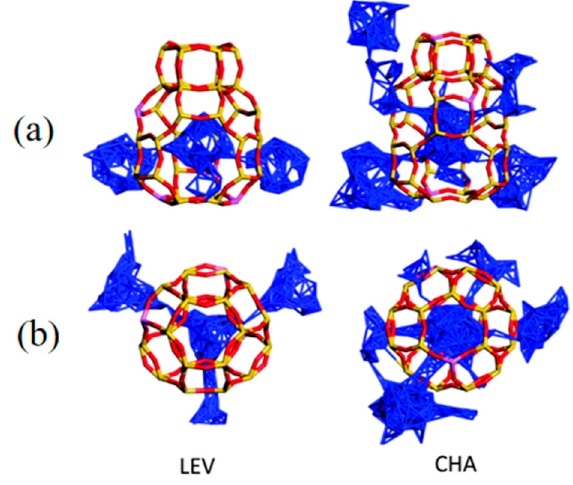
Figure 4. Center-of-mass trajectory plots of a NH 3 molecule during the MD simulations, viewed from ( a ) the side of a selected combined building unit and ( b ) above the combined building unit: reproduced with permission from [82], copyright The Royal Society of Chemistry, 2018.